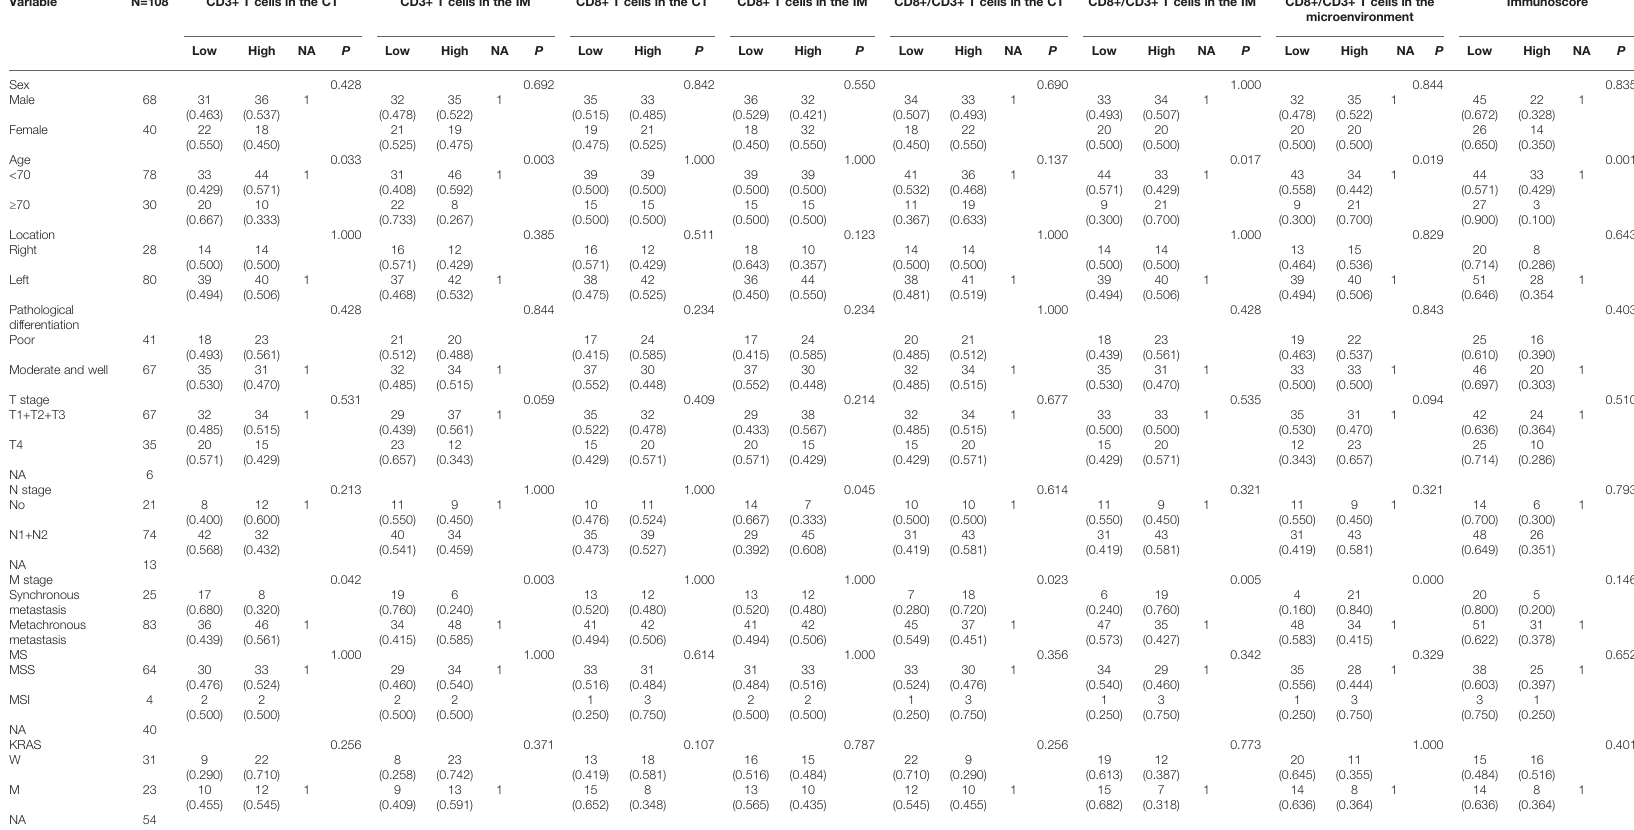
Location: The primary tumor location was classi fi ed as right-sided or left-sided according to the splenic fl exure. CT: Core of the tumor; IM: Invasive margin; NA, not